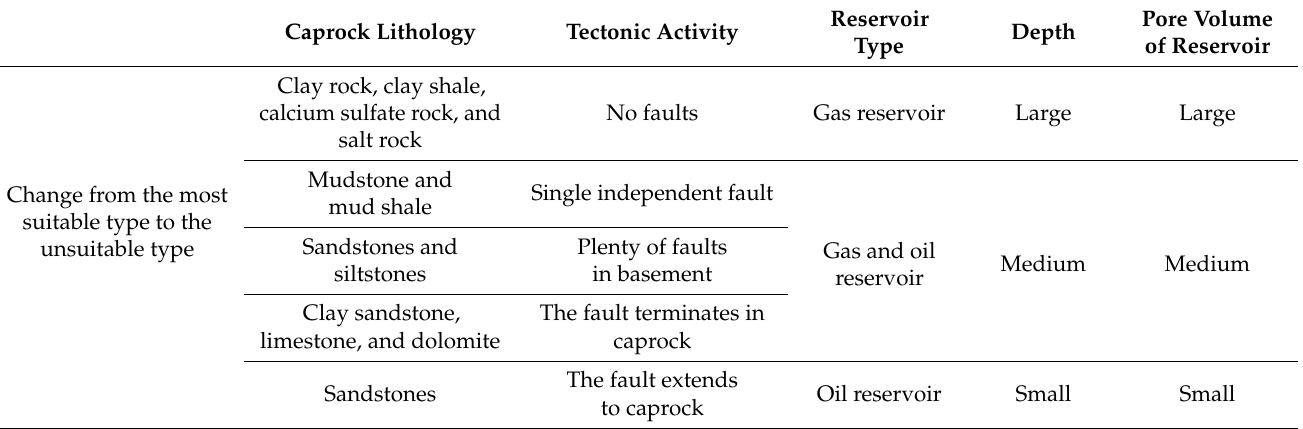
Table 1. The screen criteria for the depleted oil and gas reservoir type of UGS (modified from Lewandowska-´Smierzchalska et al.